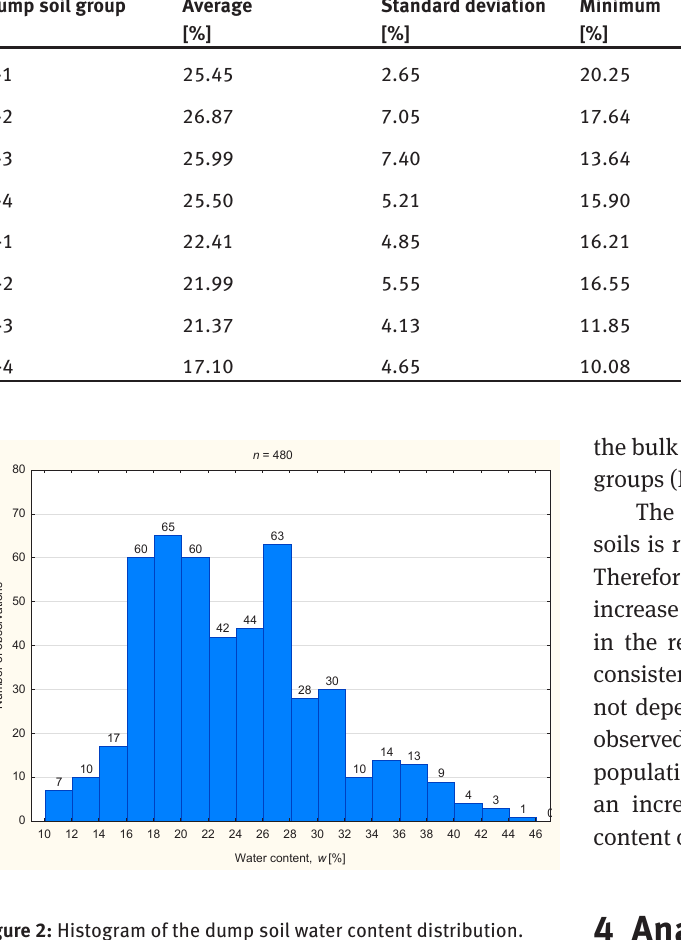
Figure 2: Histogram of the dump soil water content distribution.